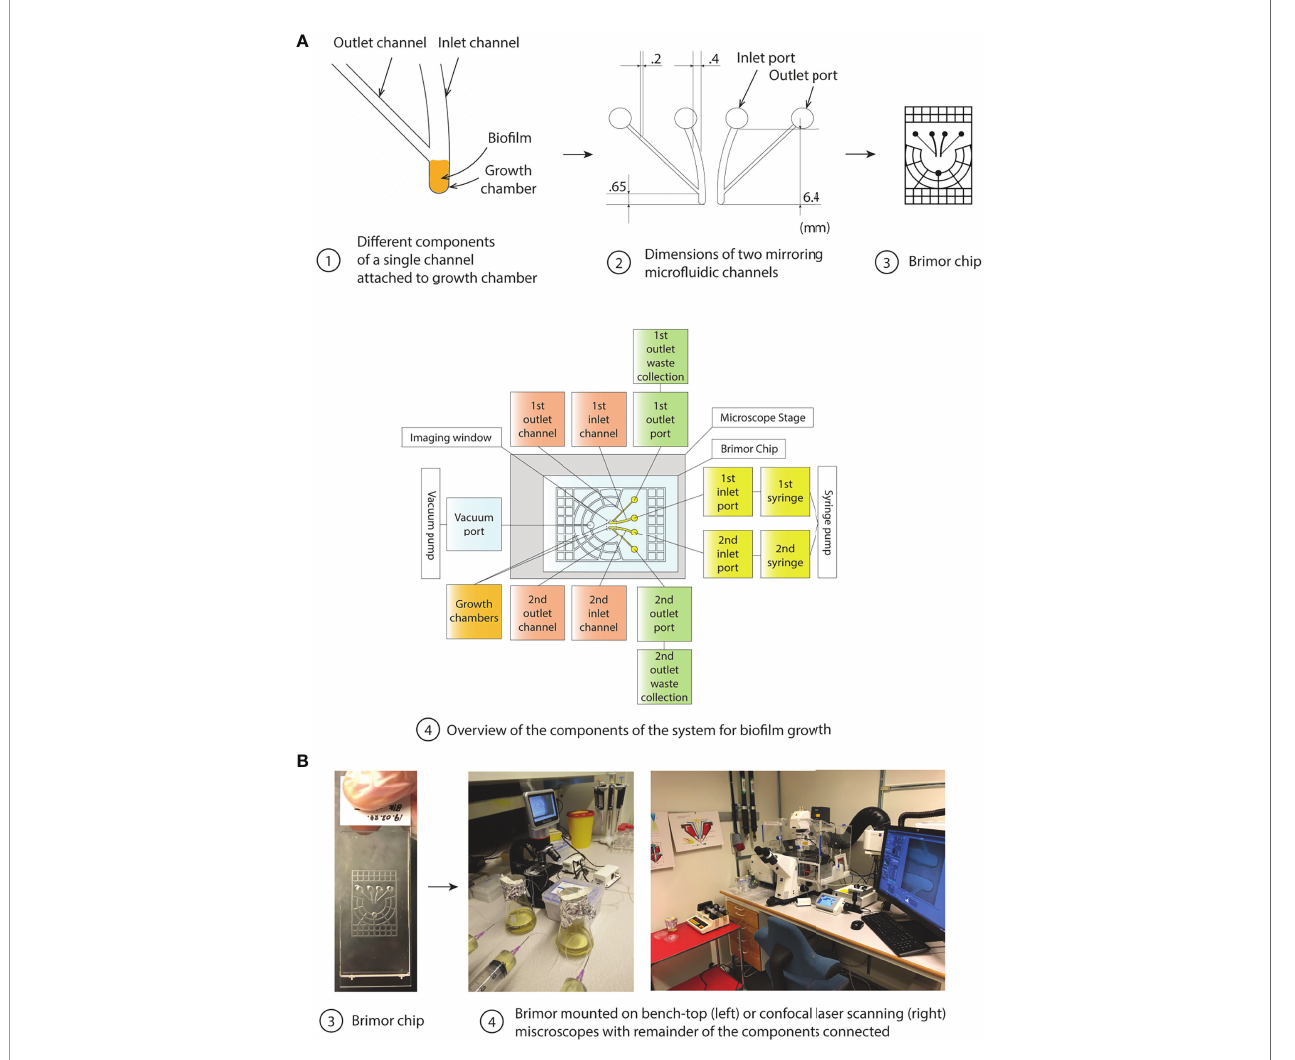
FIGURE 1 | Overview of the components of the micro fl uidic system for bio fi lm studies. (A) Illustrations indicating key features of the micro fl uidic chip. (1) The inlet fl ow channel, the bio fi lm growth chamber, and the outlet fl ow channel positioned with a 45° angle in relation to the inlet channel of the micro fl uidic chip is shown. Cells (represented by orange) proliferate and form a bio fi lm in the growth chamber which eventually fi ll up the entire volume of the growth chamber before cells (or cell aggregates) are ef fi ciently removed from the outer part of the bio fi lm due to the high fl uid sheer stress in the fl ow channels, (2) Dimensions and relative positioning of the fl ow channels and the two growth chambers in a chip, (3) Overview of the complete Brimor chip showing the vacuum grid that surrounds the centrally positioned fl ow channels and growth chambers, (4) Schematic overview of the complete system. (B) Photographs of the (3) Brimor chip and (4) complete system operated with a simple light bench-top microscope (left) or with a confocal microscope